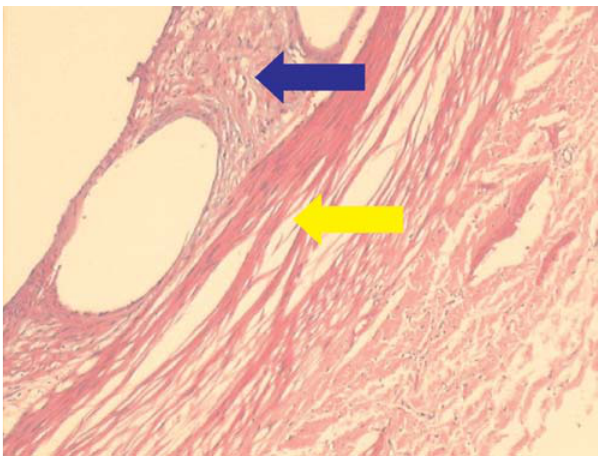
Figure 5 - Histological evaluation of aortas in Group M. Modified endothelial cells, with foam macrophages (blue arrow), were present in all specimens. No smooth muscle cells, cholesterol crystals or inflammatory cells were observed at the intima. There was elastic lamina disruption (yellow arrow) and smooth muscle cell hyperplasia, which are both characteristics of homocysteine-induced